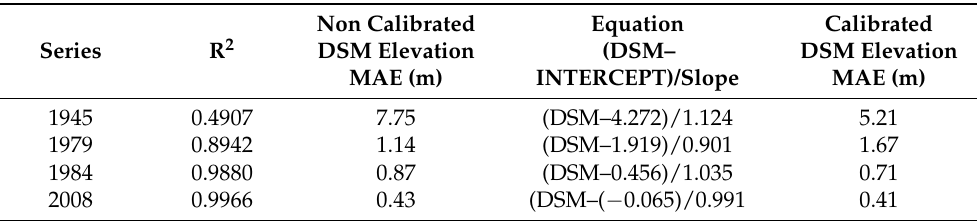
Table 3. Quality statistics of the calibrated SfM DSMs.